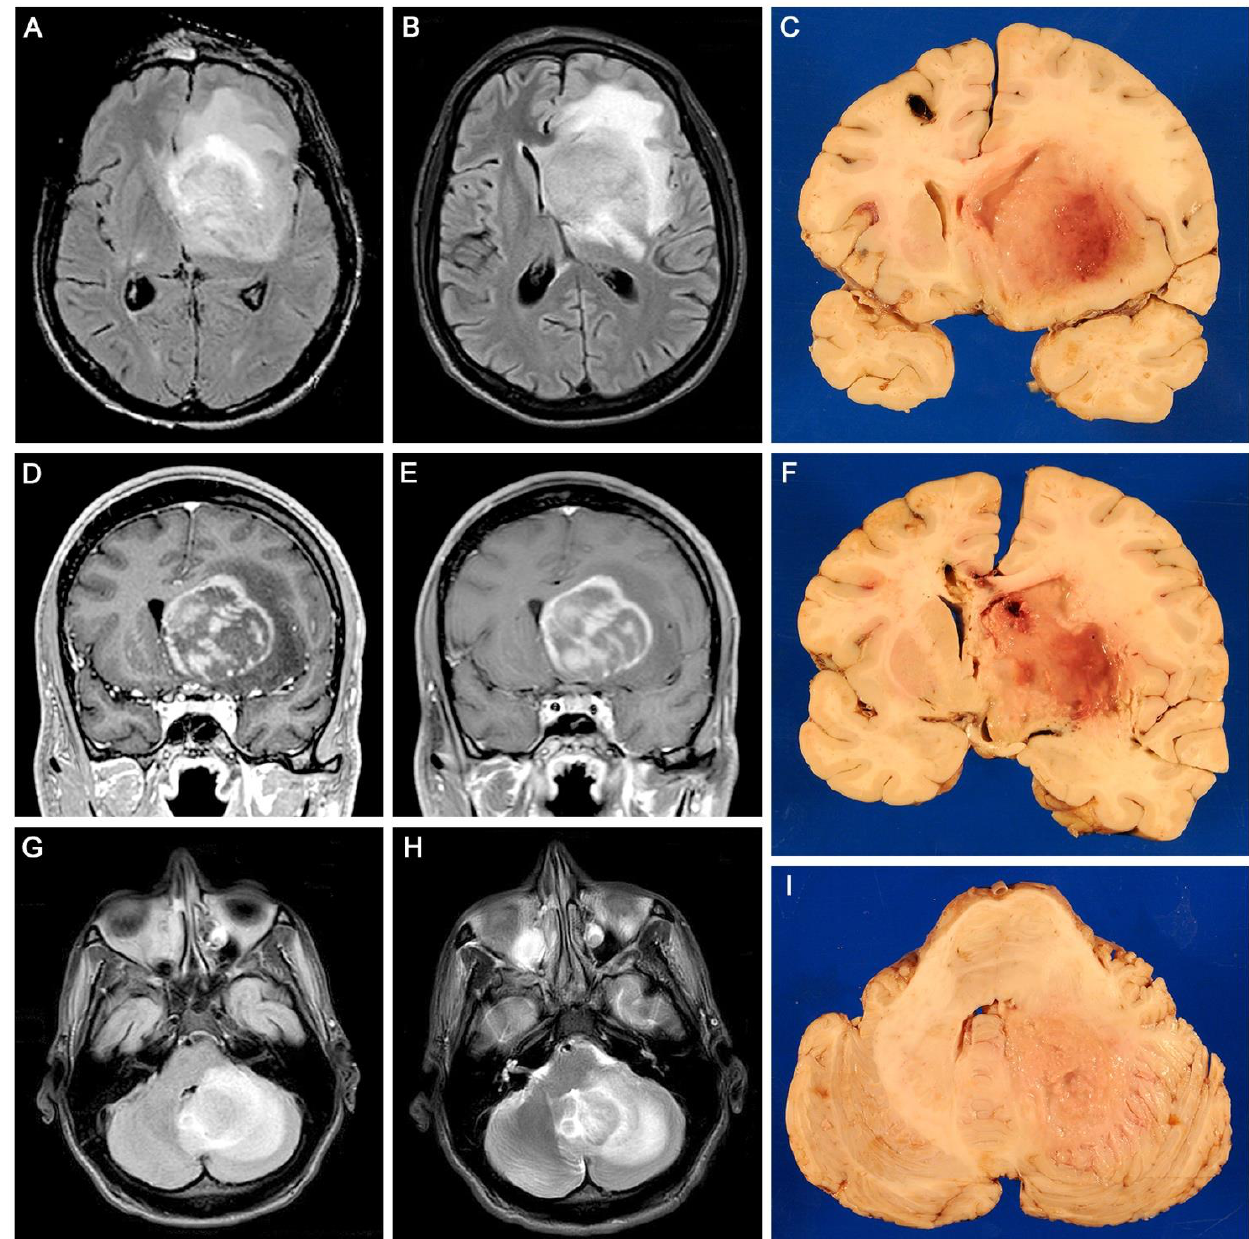
Figure 1. Neuroimaging and neuropathology: Axial plane MRI shows a large mass in the right basal ganglia which causes significant edema (Panels ( A , B )). Coronal MRI shows the mas is ring enhancing (Panels ( D , E )). Coronal sections of the brain corroborated a large mass of poorly defined edges with prominent areas of necrosis, located in the right basal ganglia with areas of necrosis, that causes significant edema and compresses the lateral ventricle; the site of the surgical probe can be seen on the contralateral frontal lobe (Panels ( A – F )). Another similar homogeneous mass can be seen in the right cerebellar hemisphere, causing a prominent midline shift (Panels ( G – I )).